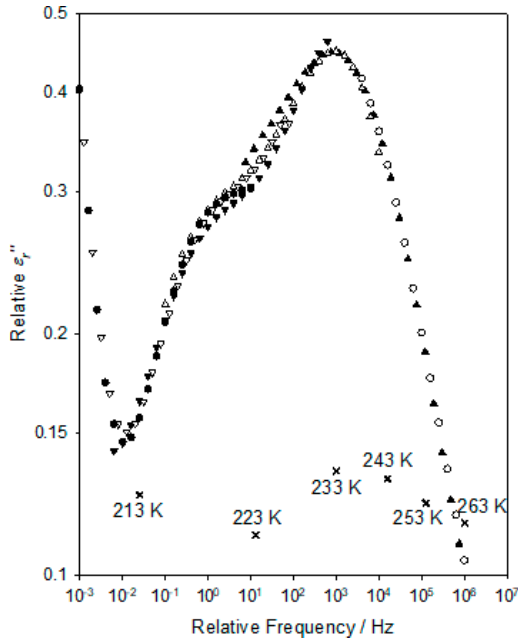
Figure 6. Dielectric relaxation master curve for the high temperature process. Data acquired at: 213 K (o), 223 K ( (cid:78) ), 233 K ( (cid:52) ), 243 K ( (cid:72) ), 253 K ( (cid:53) ), and 263 K ( (cid:4)